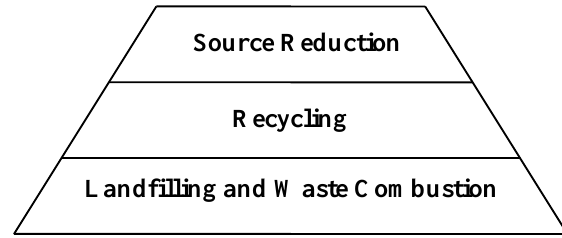
Figure 6: Integrated solid waste management